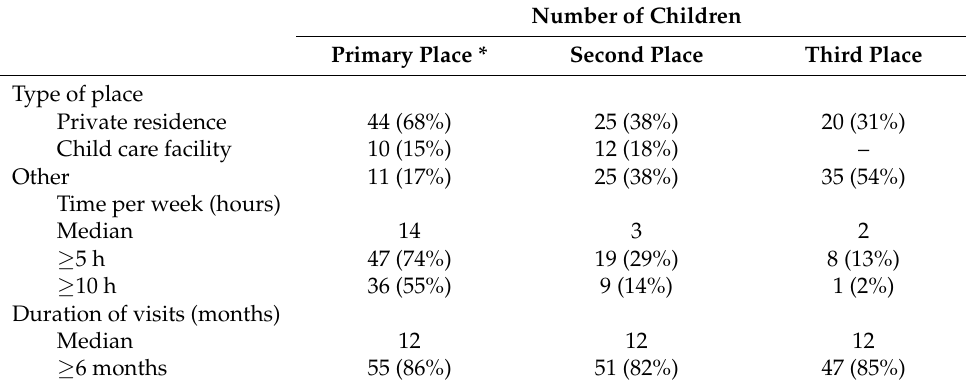
Table 2. Details of the places where young Broken Hill children spent time outside the